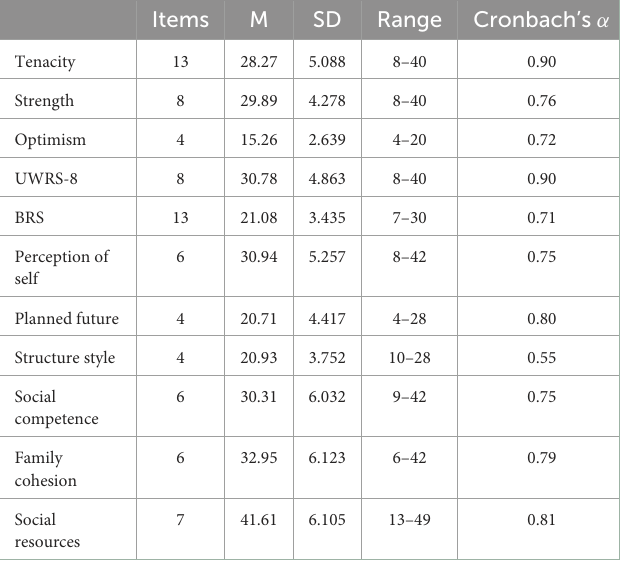
TABLE 1 Psychometric properties for resilience scales and subscales ( N =